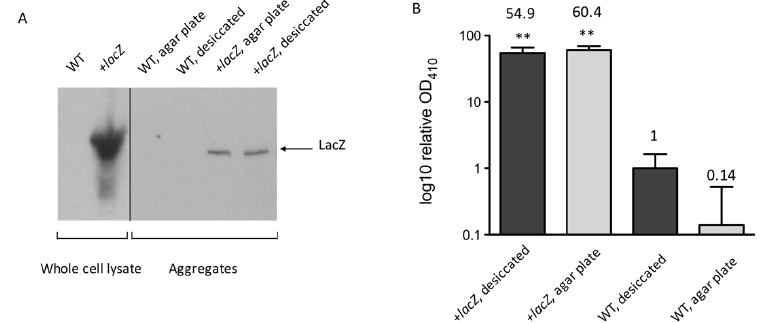
Figure 5. LacZ function detected from A. baumannii protein aggregates. ( A ) Western blot for the presence of LacZ. All the samples were prepared from 17978 grown on agar plates. LacZ was detected in the whole cell lysates of 17978 constitutively expressing lacZ from the plasmid pXW1 ( + lacZ ). LacZ was also detectable from protein aggregates in the + lacZ strain, collected from agar plate growth or after desiccation. LacZ was not detected in whole cell lysates or protein aggregates from the A. baumannii parental strain that did not encode lacZ . Equal numbers of cells were processed for whole cell lysate samples. Aggregate loading was normalized by total cellular protein concentration. The whole cell lysate samples were processed on the same gel, while the aggregate samples were processed together on a separate gel. ( B ) Protein aggregates were assayed for LacZ activity measuring ONPG cleavage at OD 410 . The signal from bu ff er was used as baseline and subtracted from all samples. LacZ activity from protein aggregates is reported relative to activity from aggregates isolated from desiccated wild type 17978 (WT, desiccated), which was set at 1. One-way ANOVA with Tukey post-hoc test showed that LacZ activity was higher (** p < 0.01) from protein aggregates extracted from A. baumannii 17978 ectopically expressing lacZ